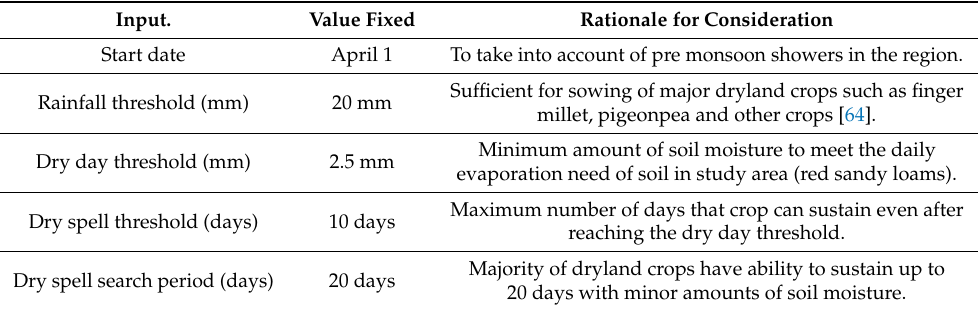
Table 7. Inputs required, fixed values and rationale behind the consideration of values for estimation of Agro-climatic onset.